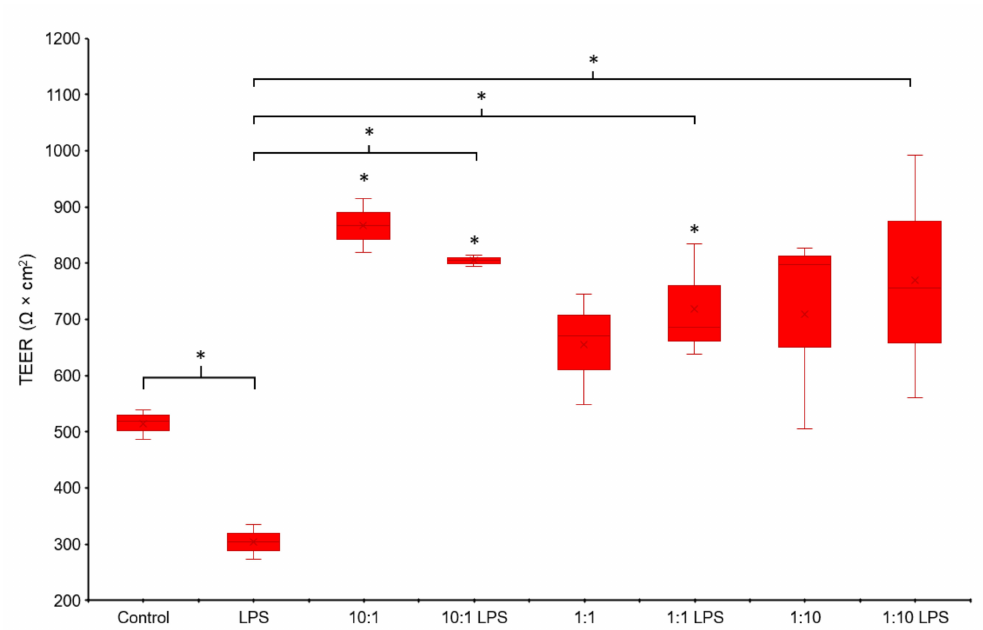
Figure 2. TEER measurement results. Caco-2 cells were challenged using three different cell/colony- forming units (CFU) ratios (i.e., 10:1, 1:1, and 1:10) for 24 h, in the absence of or in combination with an inflammatory stimulus (i.e., LPS at a 1 µ g/mL concentration) introduced 4 h after probiotic exposure. Statistical analysis: one-way ANOVA followed by Dunnett’s post hoc. Student’s t -test was used to compare control cells against the LPS-treated sample. * p -value <